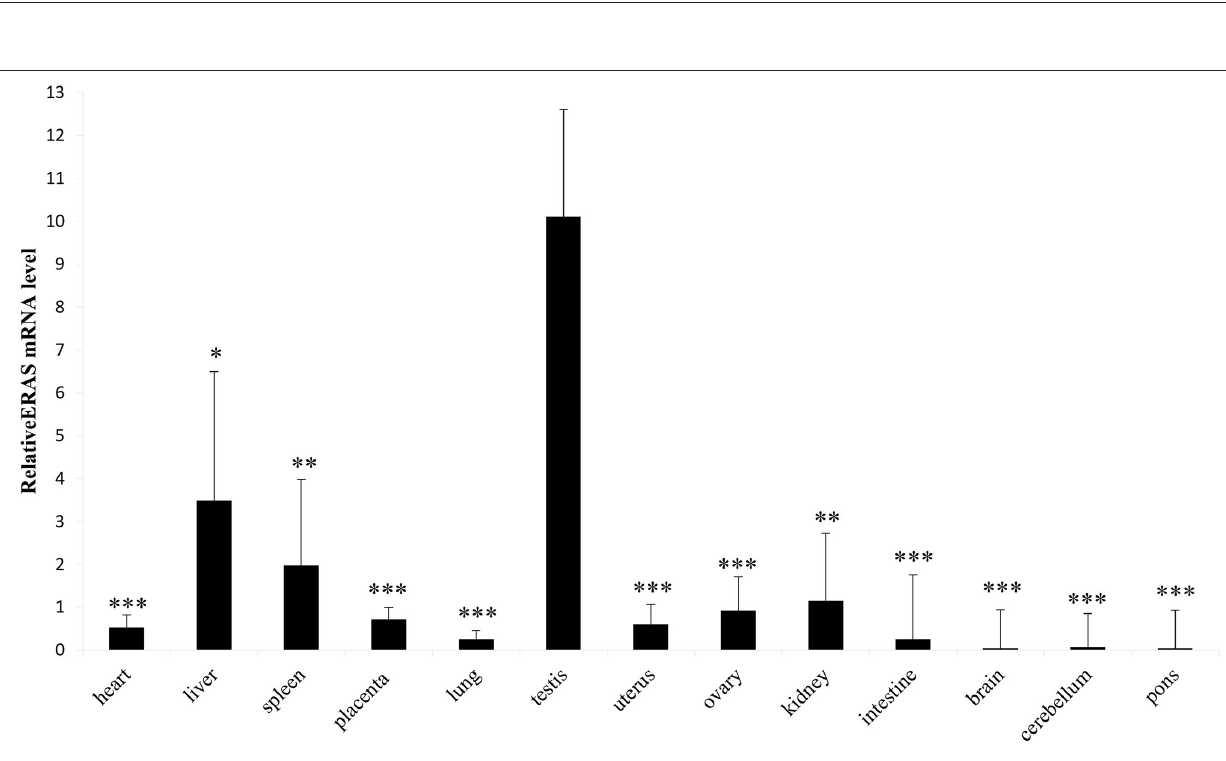
Frontiers in Veterinary Science |